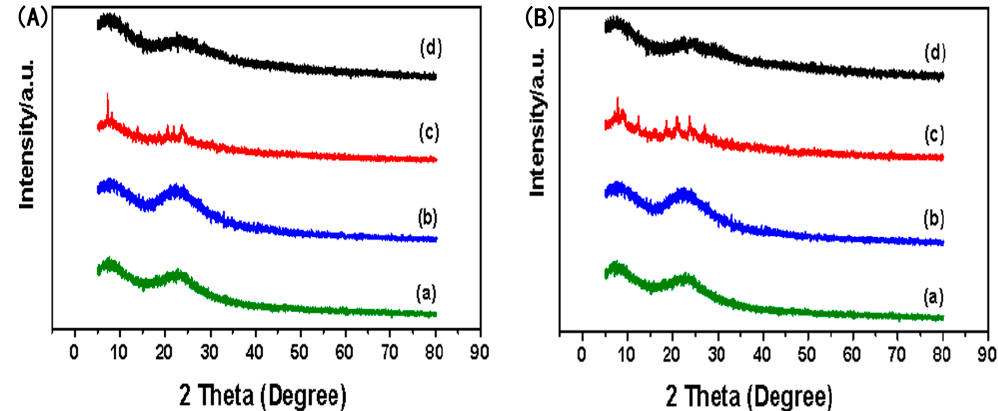
Figure 7. ( A ) X-ray powder diffraction (XRD) patterns of SiO 2 ( a ), SiO 2 @PMDA-Si ( b ), SiO 2 @PMDA-Si-Tb ( c ), and SiO 2 @PMDA-Si-Tb@SiO 2 ( d ). ( B ) XRD patterns of SiO 2 (a) , SiO 2 @PMDA-Si ( b ), SiO 2 @PMDA-Si-Tb-phen ( c ) and SiO 2 @PMDA-Si-Tb-phen@SiO 2 ( d ).